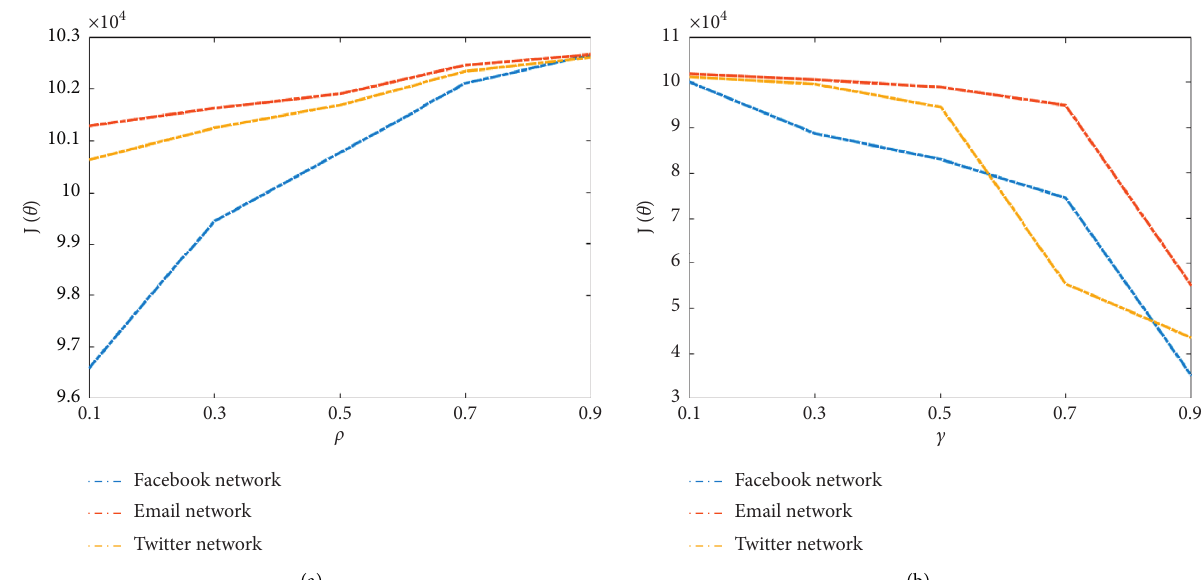
, α , α , (b) α , and (c) α 1 2 1 3